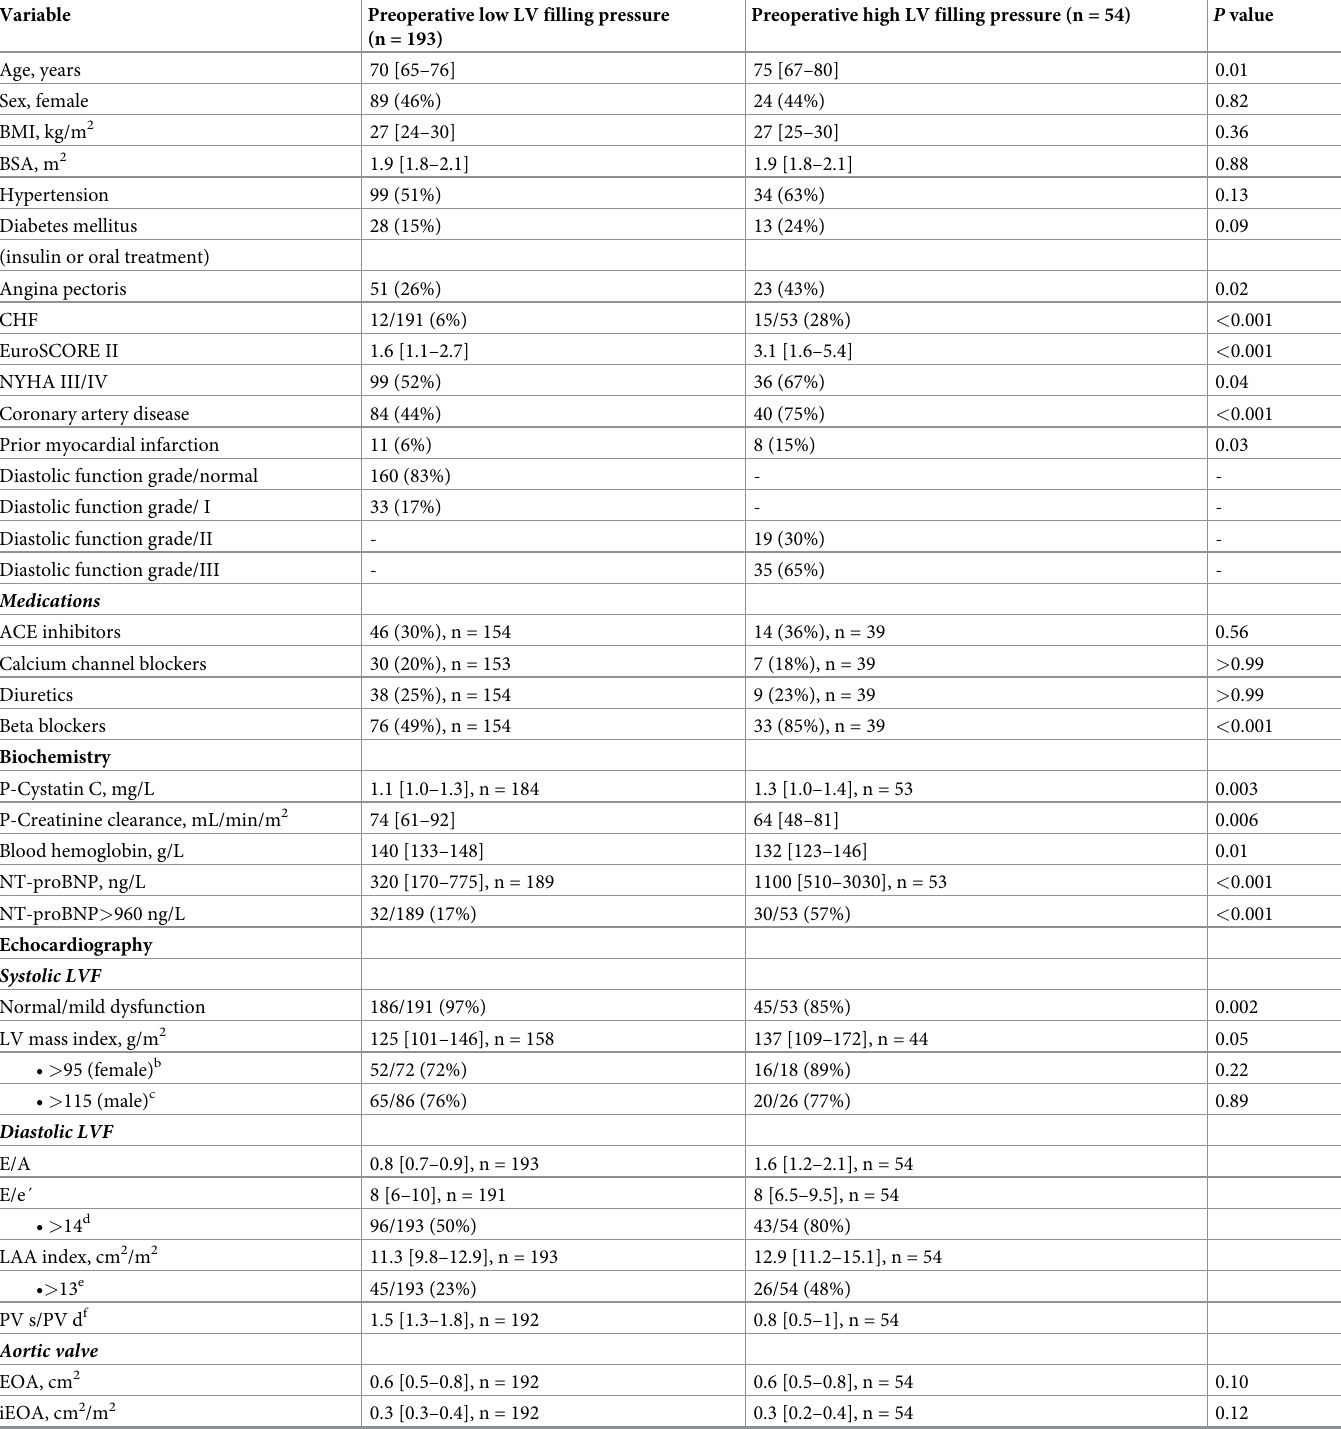
Table 1. Patients’ baseline characteristics a